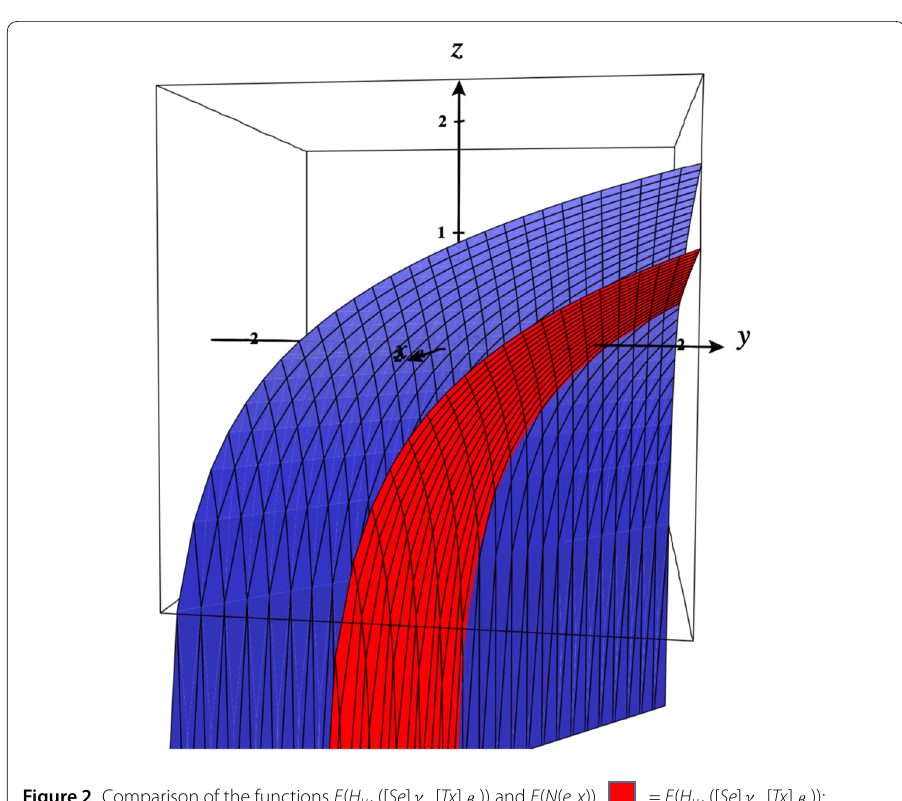
Figure 2 Comparison of the functions E ( H u (cid:3)(cid:3)(cid:3)(cid:3) = E ( N ( e , p